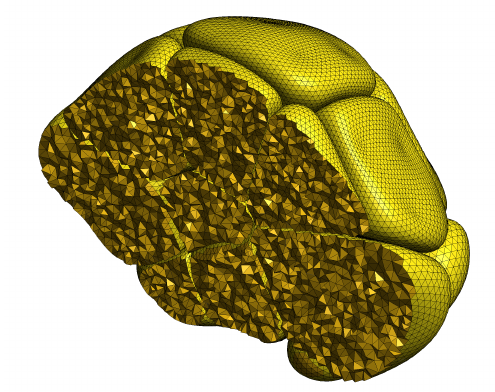
Figure 6. This cutaway view of a reconstructed acinus displays the volumetric tetrahedralization of each cell that is required by the three-dimensional finite element method used in our simulations. Additionally, the surface of each cell is partitioned into associated triangle patches, which are required in the simulation calculations for modelling boundary